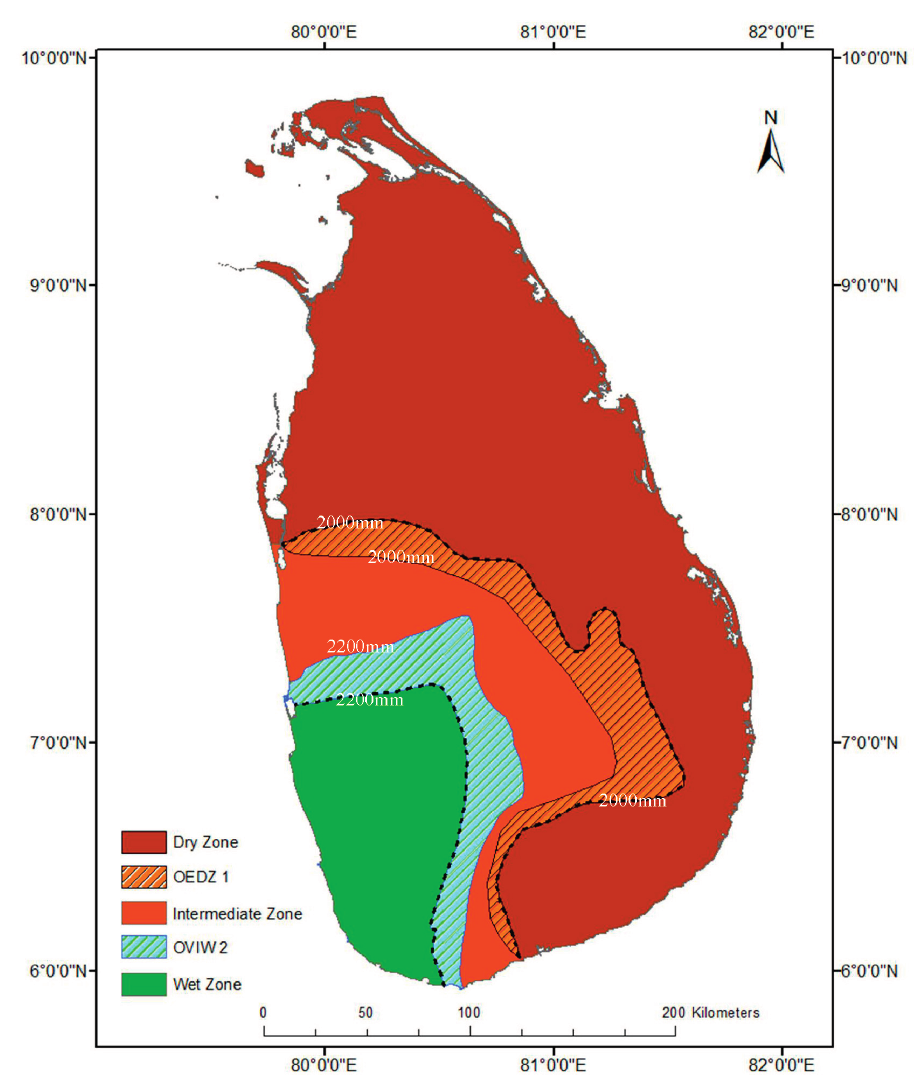
Figure 3. Isohyet changes in climate zone in Sri Lanka from 1962 to 2002. (The map is illustrated based on the analysis of the Manawadu and Fernando research study